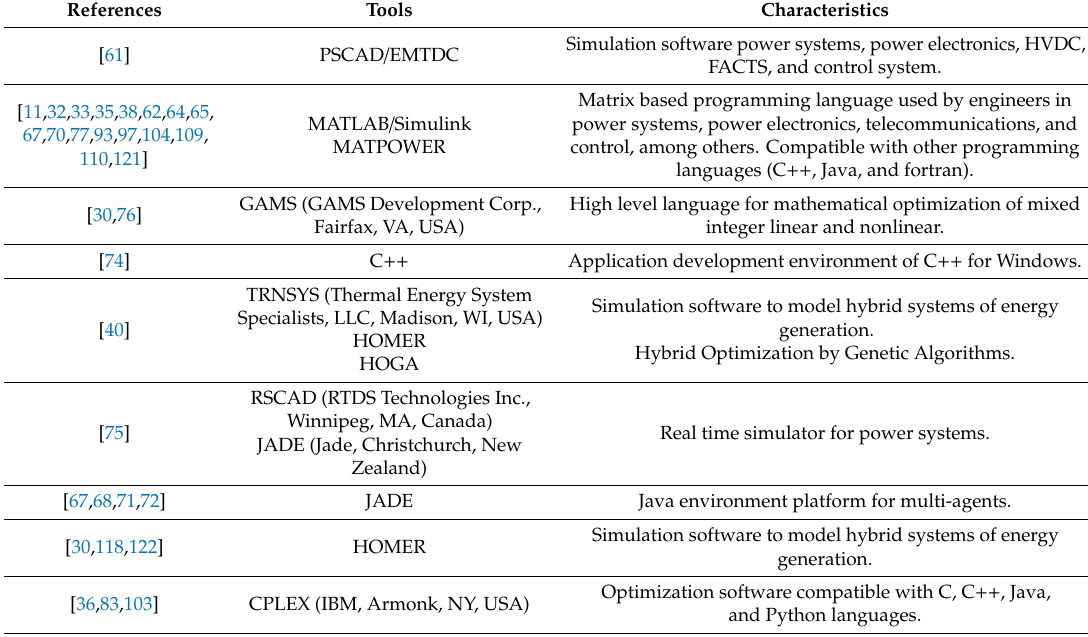
Table 5. Simulation software and tools used in the management of